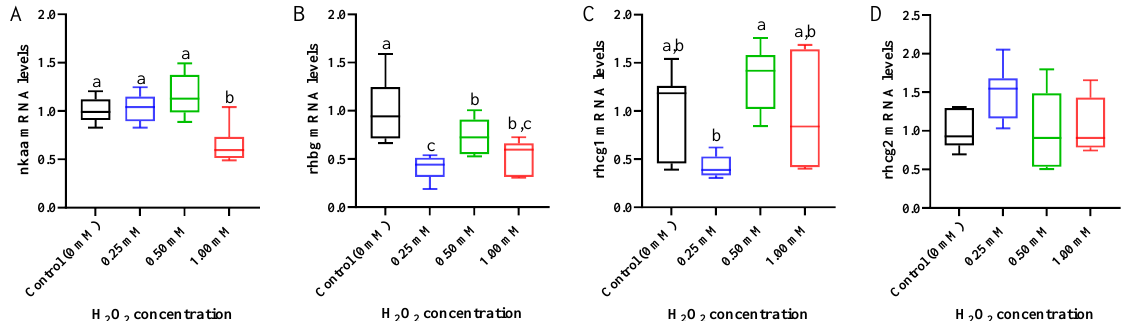
Figure 5. Activities of Na + /K + -ATPase ( A ), Ca 2+ /Mg 2+ -ATPase ( B ), and H + /K + -ATPase ( C ) in gills of Cyprinus carpio under H 2 O 2 exposure. Data are expressed as mean ± SE (n = 9). The different letters above each bar indicate a statistical significance among different concentrations of H 2 O 2 exposure ( p < 0.05).